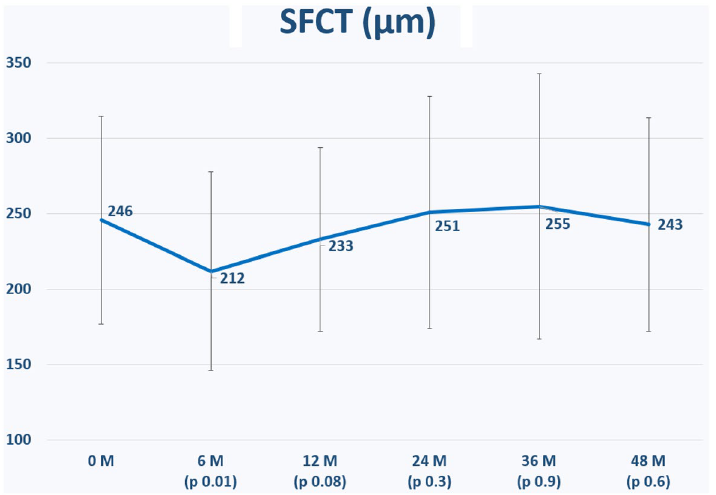
Figure 5. The change in subfoveal choroidal thickness (SFCT, µm) during the study observation period. p values refer to statistical differences between each time points and baseline: SFCT improved significantly only 6 months after the first intravitreal injection (p =